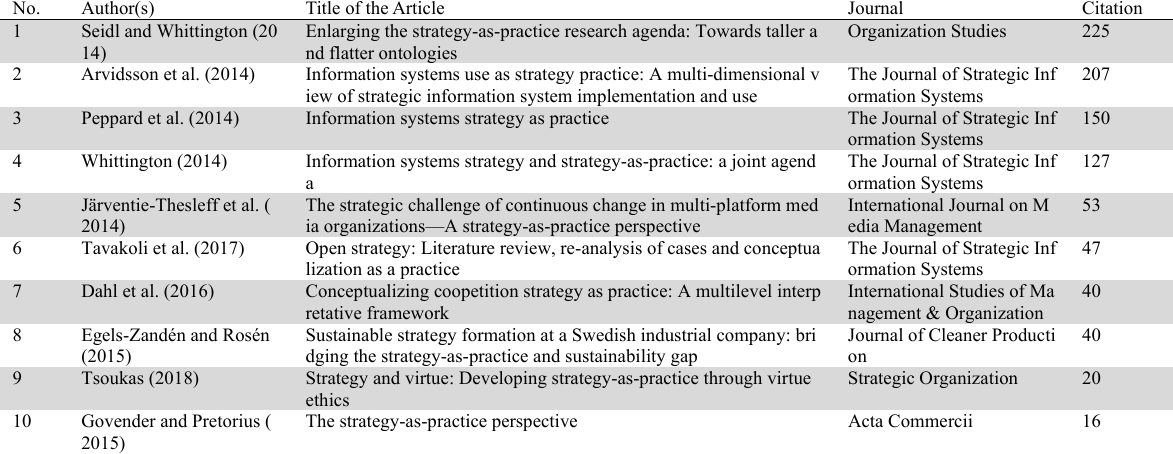
Most recent individual pieces of work on the concept of strategy-as-practice over the last five years (between 2014 and 2019) and according to the citation